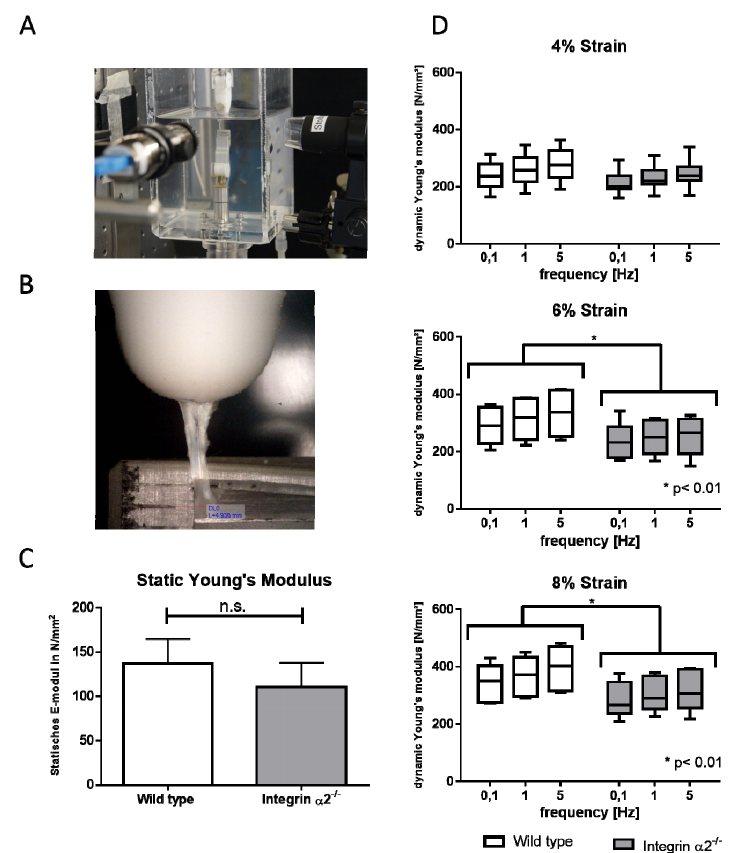
Figure 3. Biomechanical testing set-up ( A ) with the mounted tendon ( B ). Static Young’s modulus at the load to failure ( C ). Dynamic Young’s modulus measured at 0.1 Hz, 1 Hz and 5 Hz straining the tendon at 4%–8% ( D ) N = 8. Statistic analysis: Mann-Whitney U test was used for the static biomechanical testing (n.s. p > 0.05), and two-way ANOVA was used for the dynamic biomechanical testing, (* p <